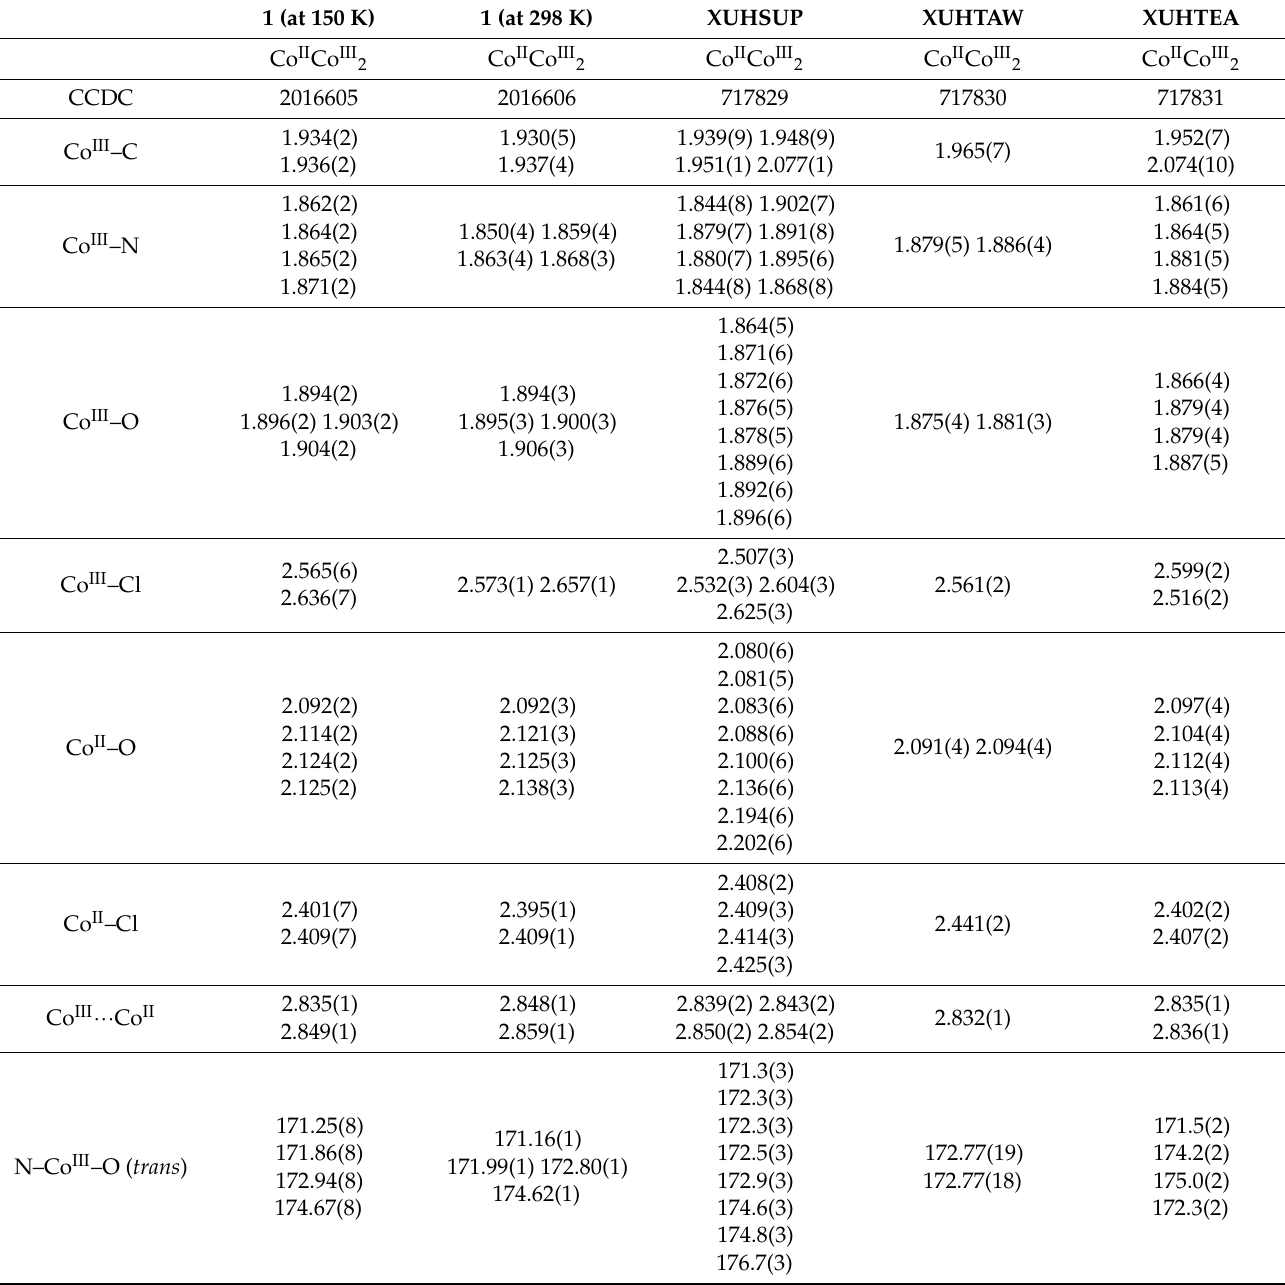
Table 1. Comparison of selected structural parameters (distances in Å and angles in ◦ ) of 1 (at 150 and 298 K) and other related Co II Co III 2 compounds. Reported compounds are presented by their CCDC reference codes and deposition numbers